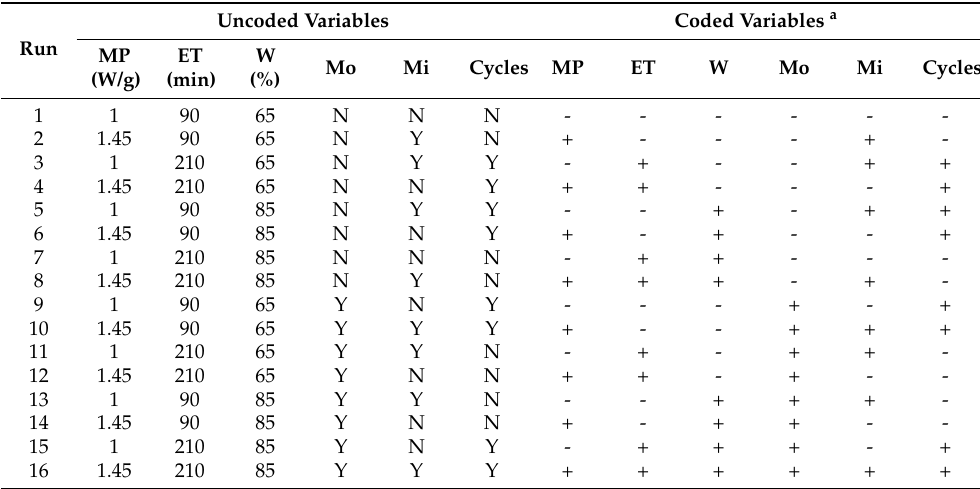
Table 1. Experimental conditions both in uncoded and coded variables of the sixteen runs carried out, according to the screening